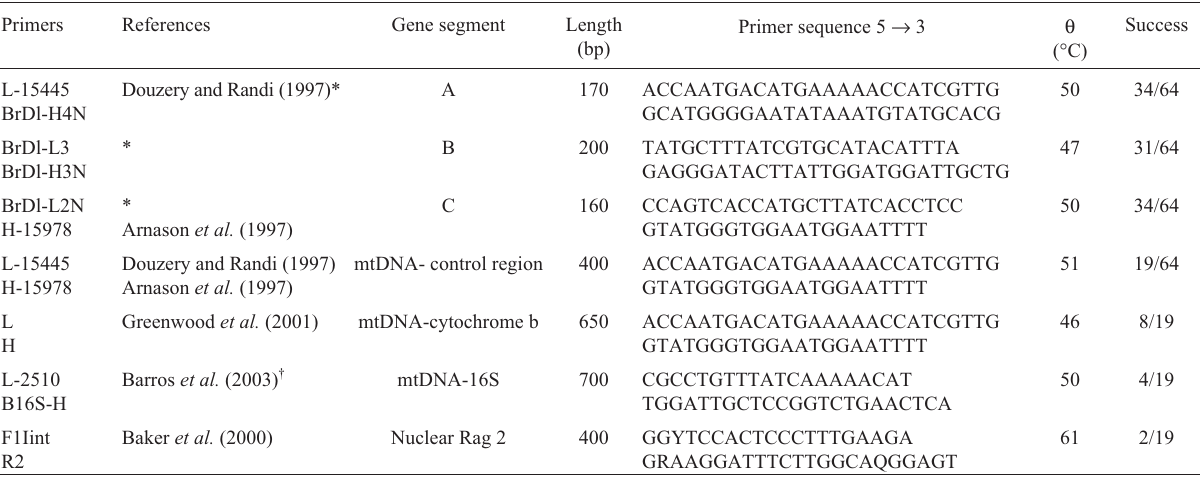
Table 2 - Primer details, annealing temperature ( θ ) and rate of success expressed as the number of valid sequences divided by the number of specimens tested.